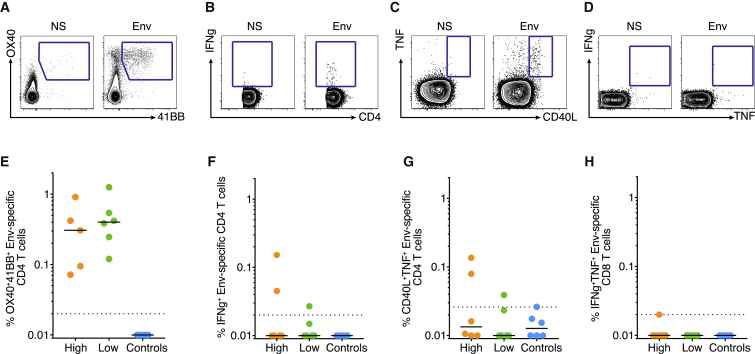
HIV Env-Specific CD4+ T Cells and Env-Specific CD8+ T Cells at Week 0 Are Not Associated with the Observed Protection from Infection(A–C) Representative flow plots of Env-specific CD4+ T cells from week 0 PBMCs: using an OX40/4-1BB AIM assay (Reiss et al., 2017) (A), intracellular staining (ICS) assay for IFN-γ (B), and ICS assay for TNF/CD40L (C) when not stimulated (NS) versus stimulated with antigen (Env).(D) Representative flow plot of IFN-γ and TNF expression in CD8+ T cells by ICS when not stimulated (NS) versus stimulated with antigen (Env).(E–G) Quantification of the percent of CD4+ T cells that are Env-specific based on: OX40/4-1BB (E), IFN-γ (F), or CD40L/TNF (G) expression.(H) Quantification of the percent of CD8+ T cells that are Env-specific based on IFN-γ and TNF expression. Signal from the unstimulated condition was subtracted from the antigen-specific signal for each sample. Each dot represents an individual animal. Shown are high and low nAb titer, as well as control group animals.See also Figure S6.